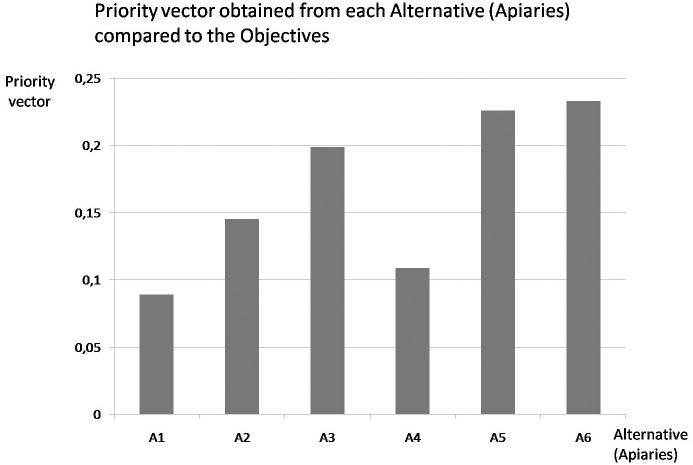
Results of the analytic hierarchy process (AHP).